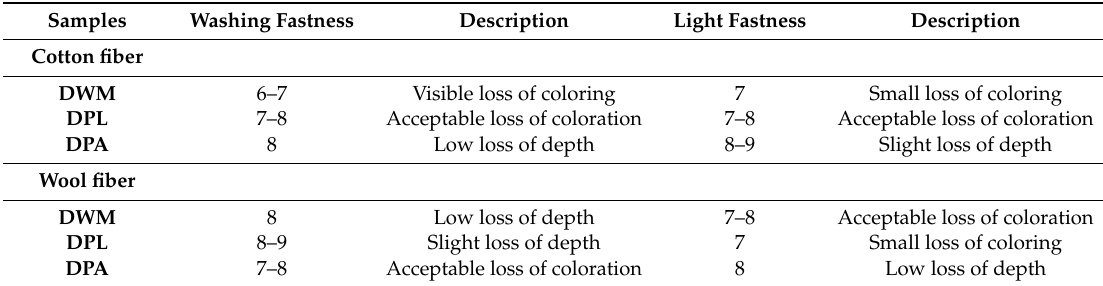
Table 4. Washing and light fastness values for the colored